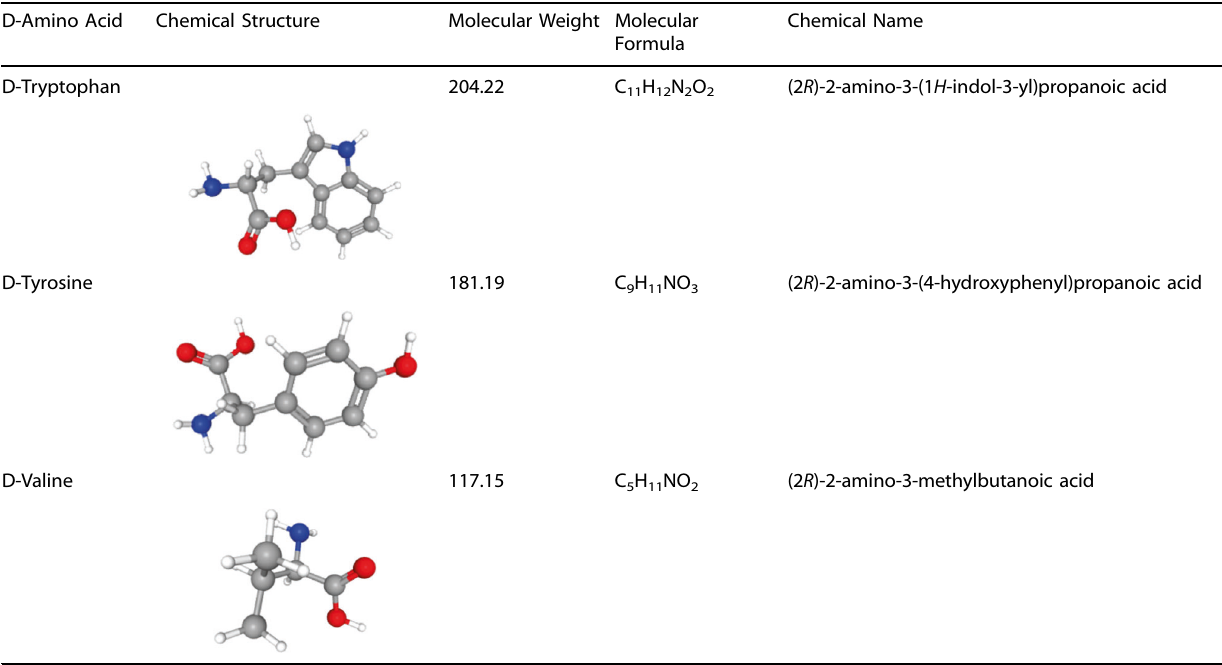
Ball and Stick components: red = oxygen, blue = nitrogen, yellow = sulphur, and white = hydrogen. Information was sourced from the National Library of Medicine, National Center for Biotechnology information